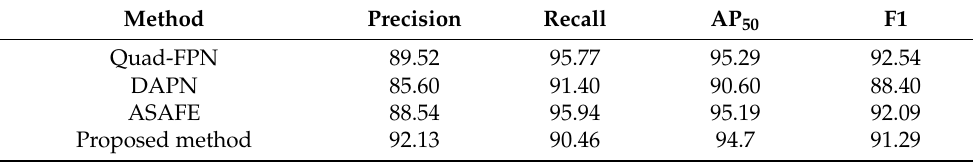
Table 7. Comparison with current SAR ship detection methods on the SSDD